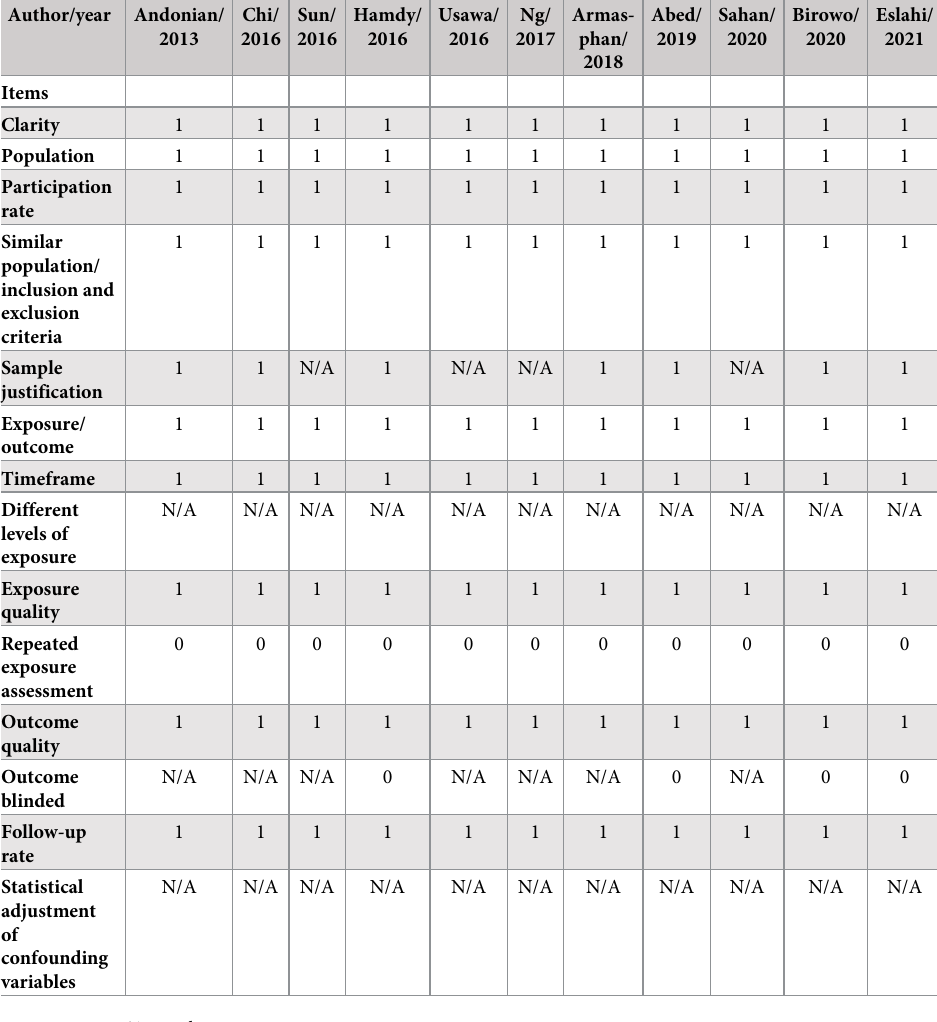
Table 2. Results of quality assessment of cohort